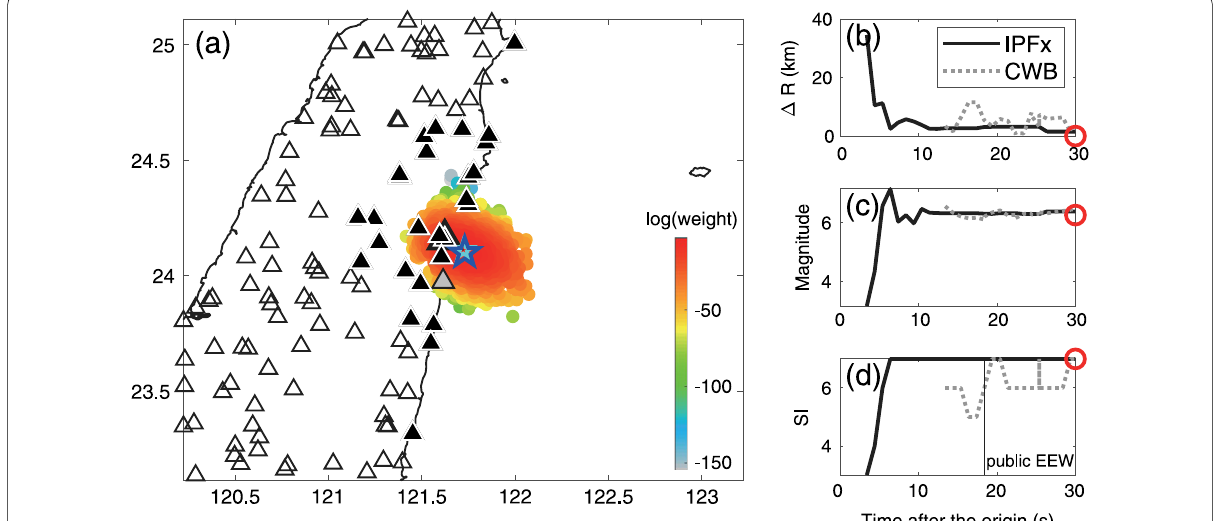
Fig. 4 Result of the Hualien mainshock on February 6, 2018. a Estimated source location at convergence time. Small and large stars indicate the optimal estimation and the CWB manual catalog, respectively. Black and gray triangles indicate triggered and non‑triggered stations in the estimation group of this event, respectively. Open triangles indicate seismic stations. Colors indicate the particle weight. b – d Time frame of estimated earthquake parameters after origin time. Thick and broken lines indicate the result of the IPFx and CWB EEW methods, respectively. The circle at the right end shows the values in the JMA manual catalog. b Location error, c magnitude, and d seismic